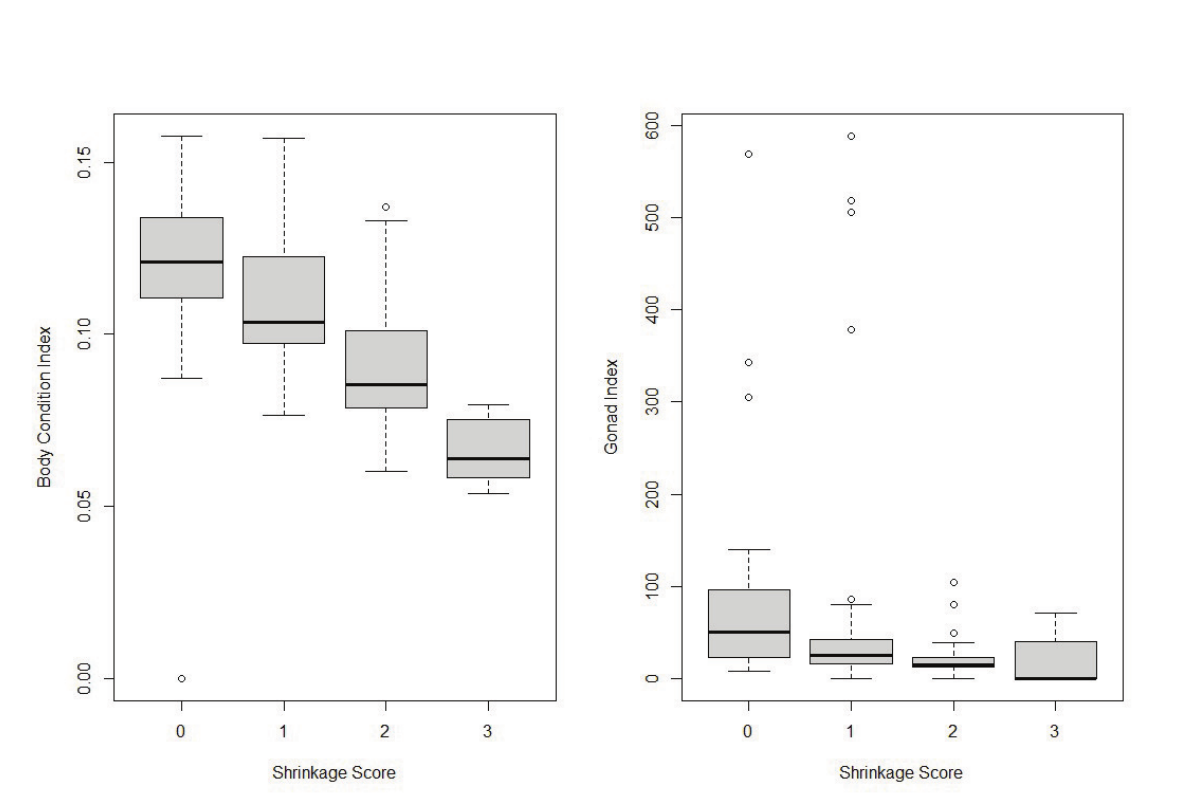
FIGURE6 Boxplots of body condition index ( left ) and gonad index ( right ) by shrinkage score in 2016 and 2017 from Van Damme State Park (males and females combined). Baseline Body Index (2000–2009) = 0.144 (se = 0.001) Baseline Gonad Index (2000–2009) = 507 (se =